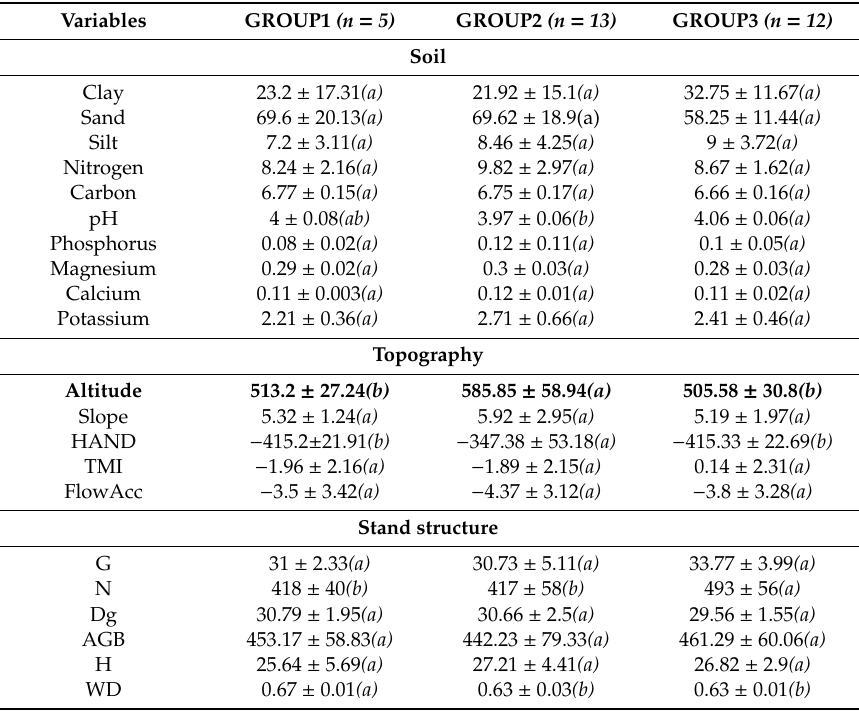
Table 2. Relationship between floristic groups and structural and topo-soil-related variables. Significant di ff erences at P < 0.05 for each variable between the floristic groups, obtained from multiple comparison tests with Bonferroni adjustment, are shown between brackets. For a given variable, groups with the same bracketed letters are not significantly di ff